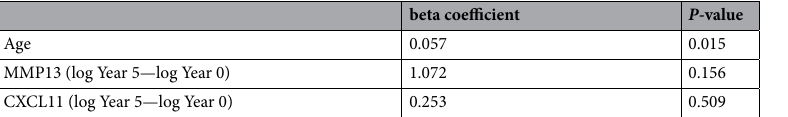
Table 4. Relationship between selected risk factors and progression of RA-ILD. Descriptive analyses showed differences in risk of RA-ILD progression for age, RF, and changes (log Year 5-log Year 0) in serum levels of CXCL11/ITAC and MMP13. We conducted Spearman correlation analyses for continuous variables to exclude highly correlated variables (r > 0.5 and p < 0.05) from the final logistic regression model in order to avoid multicollinearity. Based on these considerations and impact on AIC values, age, MMP-13 (log Year 5-log Year 0), and CXCL11 (log Year 5-log Year 0) were selected to include in the final